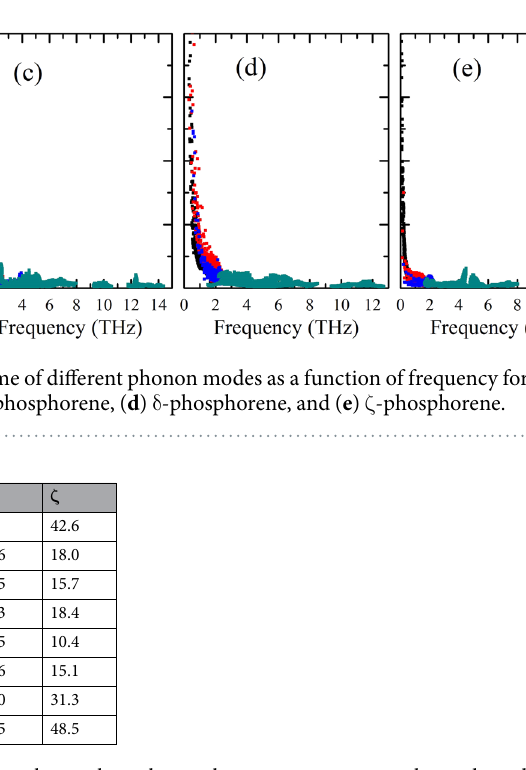
Table 3. Percentage contribution of different phonon branches to the room temperature thermal conductivity for the five phosphorene allotropes.